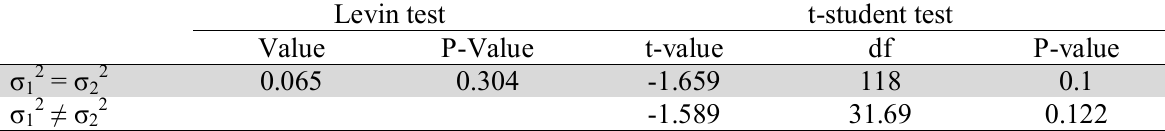
The summary of t-student and Levin tests